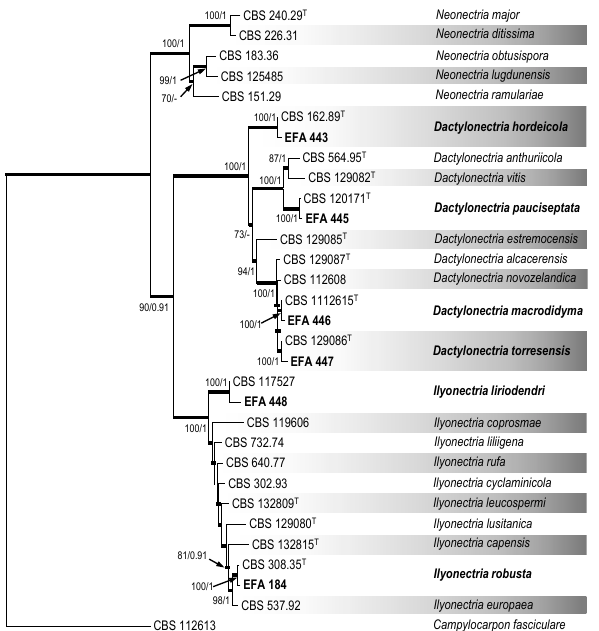
Figure 3. Phylogram generated from Maximum Likelihood analysis of Cylindrocarpon species isolated in this study and their closely related species based on combined ITS, LSU, his3 , tef1 and tub2 sequence data. Thickened branches are those present in the maximum likelihood and Bayesian inference trees. Bayesian posterior probabilities ≥0.90 and bootstrap support values for ML ≥70% are indicated at the nodes. The tree was rooted to Campylocarpon fasciculare (CBS 122613). Isolates obtained in this study are in bold and ex-type reference strains are indicated with T . The scale bar represents the expected changes per